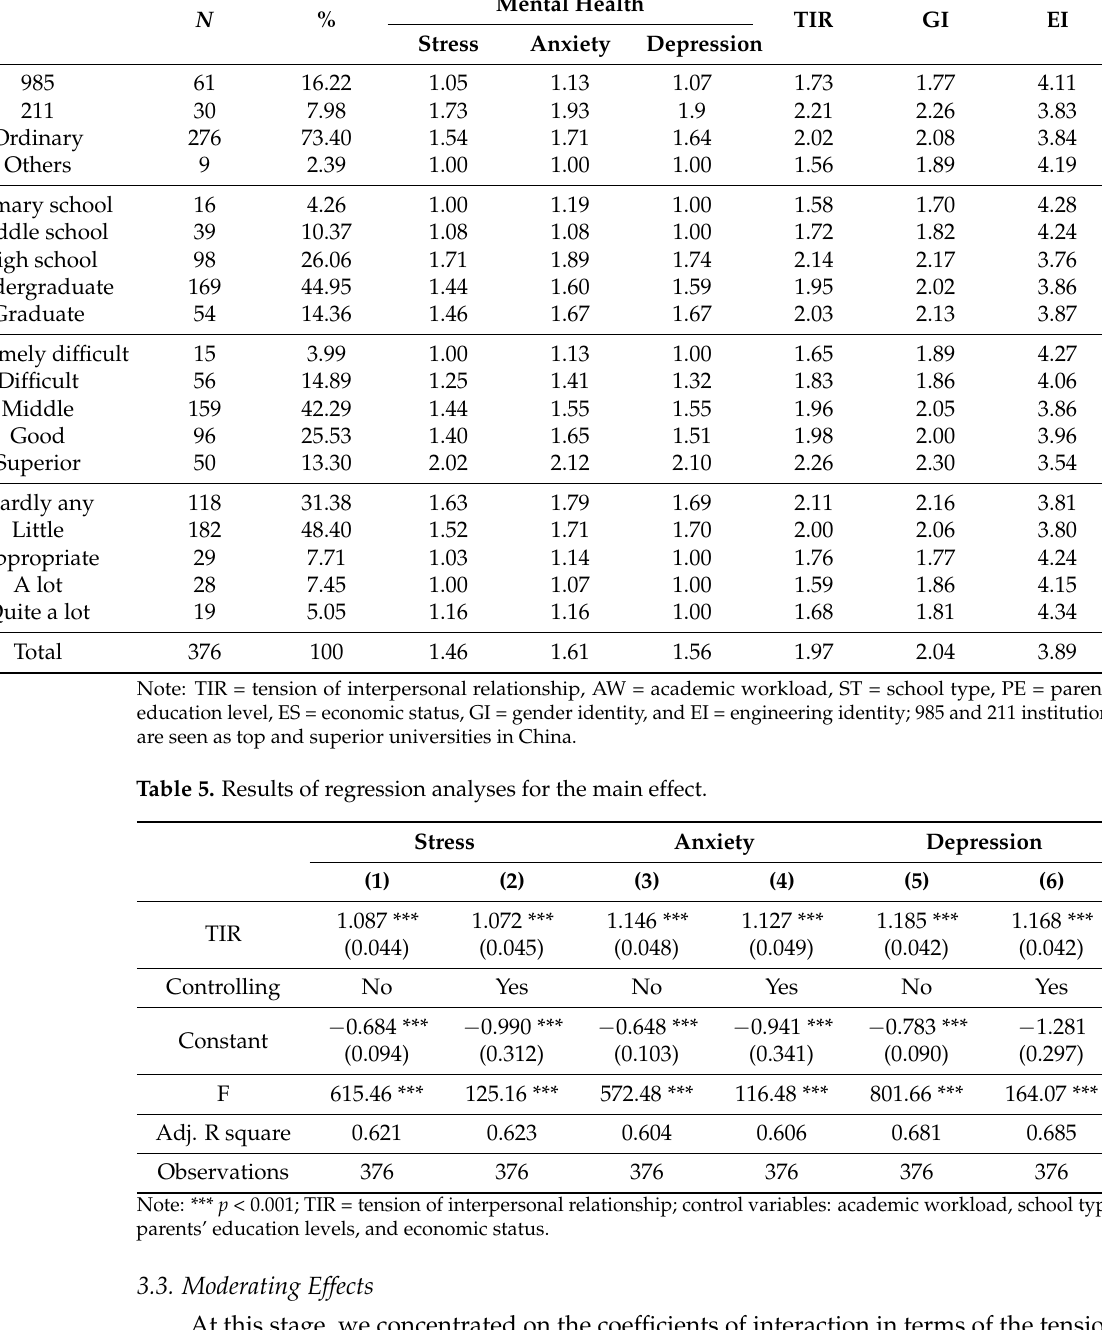
Table 4. Number and percentage of self-reported stress, anxiety, and depression by covariates ( N = 376). Mental Health N % TIR GI EI Stress Anxiety Depression